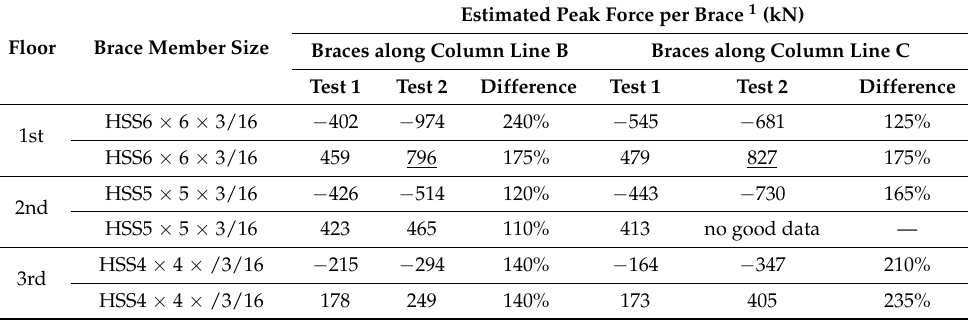
Table 8. Test 1—Peak measured braces forces from strain gauge data (refer to Figure 8 for strain gauge